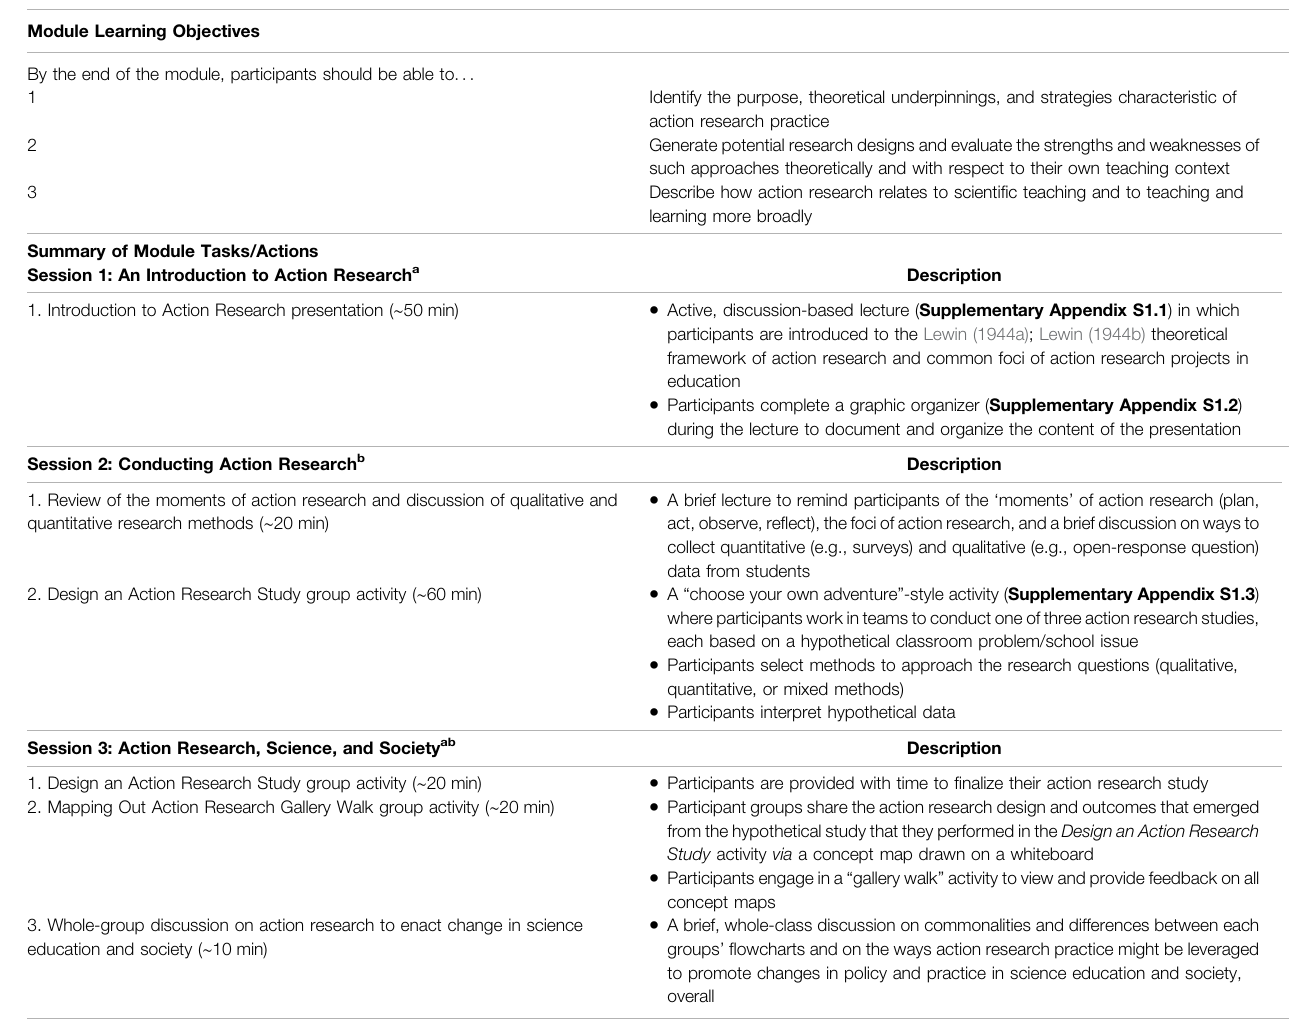
TABLE 3 | Module learning objectives and lesson